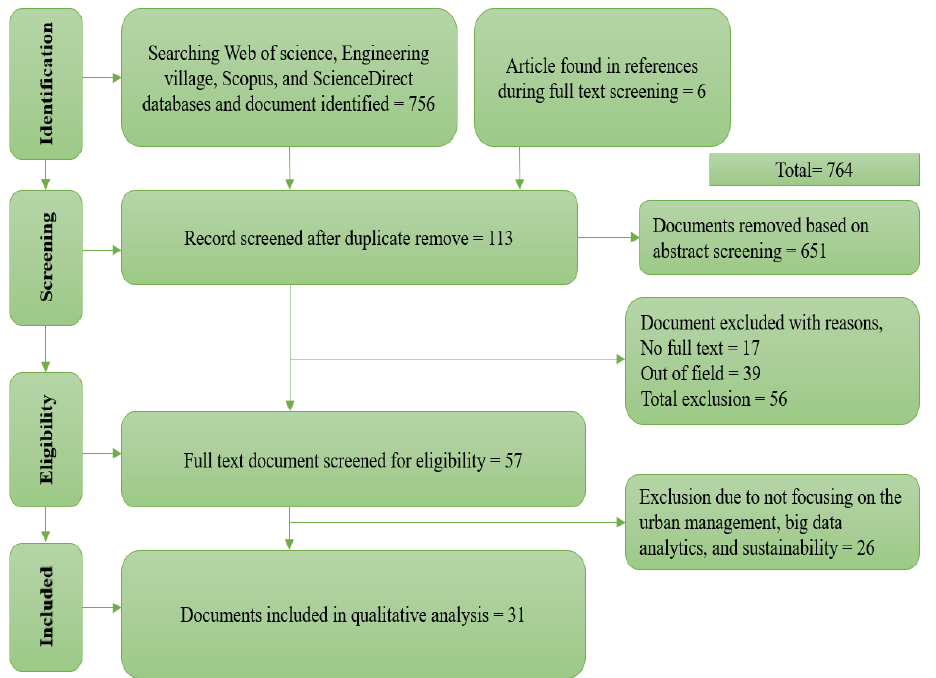
Figure 1. Document selection guided by PRISMA approach.